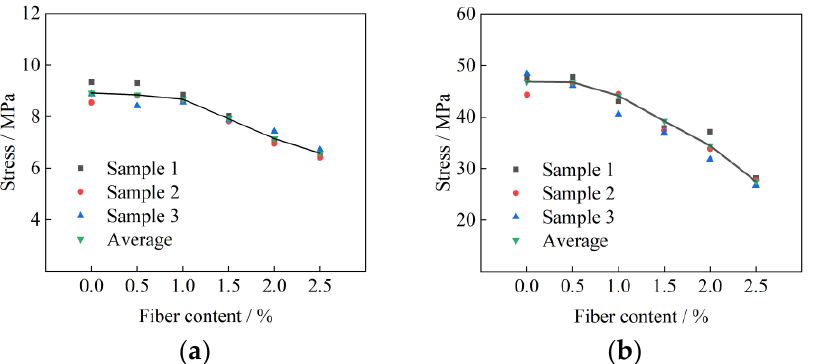
Figure 3. Effect of different fiber content on the peak stress of the specimen: ( a ) concave hexagonal unit cells; ( b ) cubic specimens.